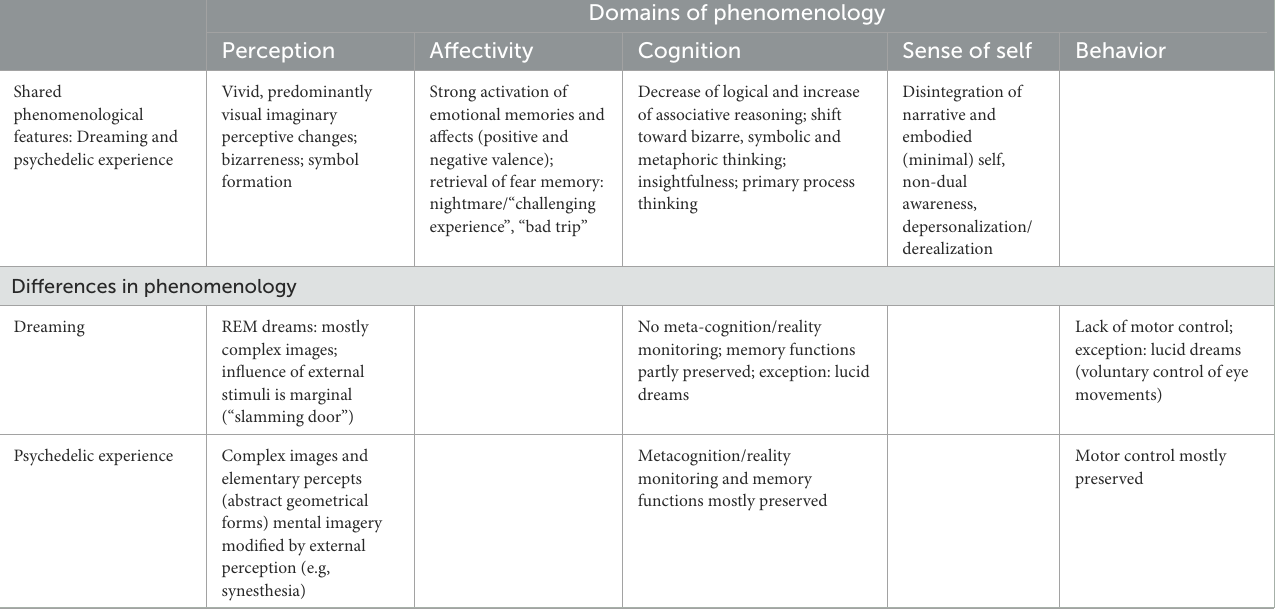
TABLE 2 Phenomenology of dreaming and the psychedelic